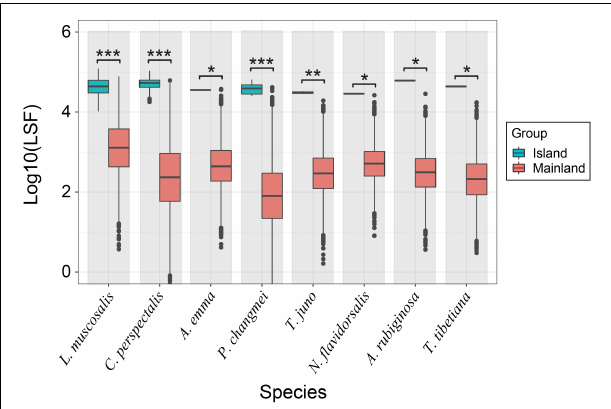
FIGURE 5 | Comparison of the flight ability of the trans-island populations of each species and the mainland stranded population (species dispersal from the mainland to island). The eight selected species are displayed on the x -axis, and the y -axis is the log10 conversion value of the LSF parameters of the different populations of each species. The difference between different populations is calculated by the Wilcoxon rank sum-test of the one-tailed